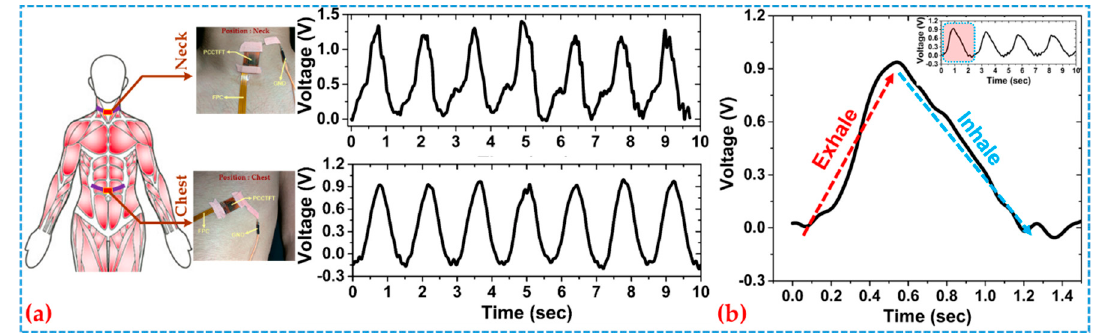
Figure 3. Dynamic response of the sensor at two peripheral points of ( a ) neck and chest; ( b ) signal of one complete respiration cycle.